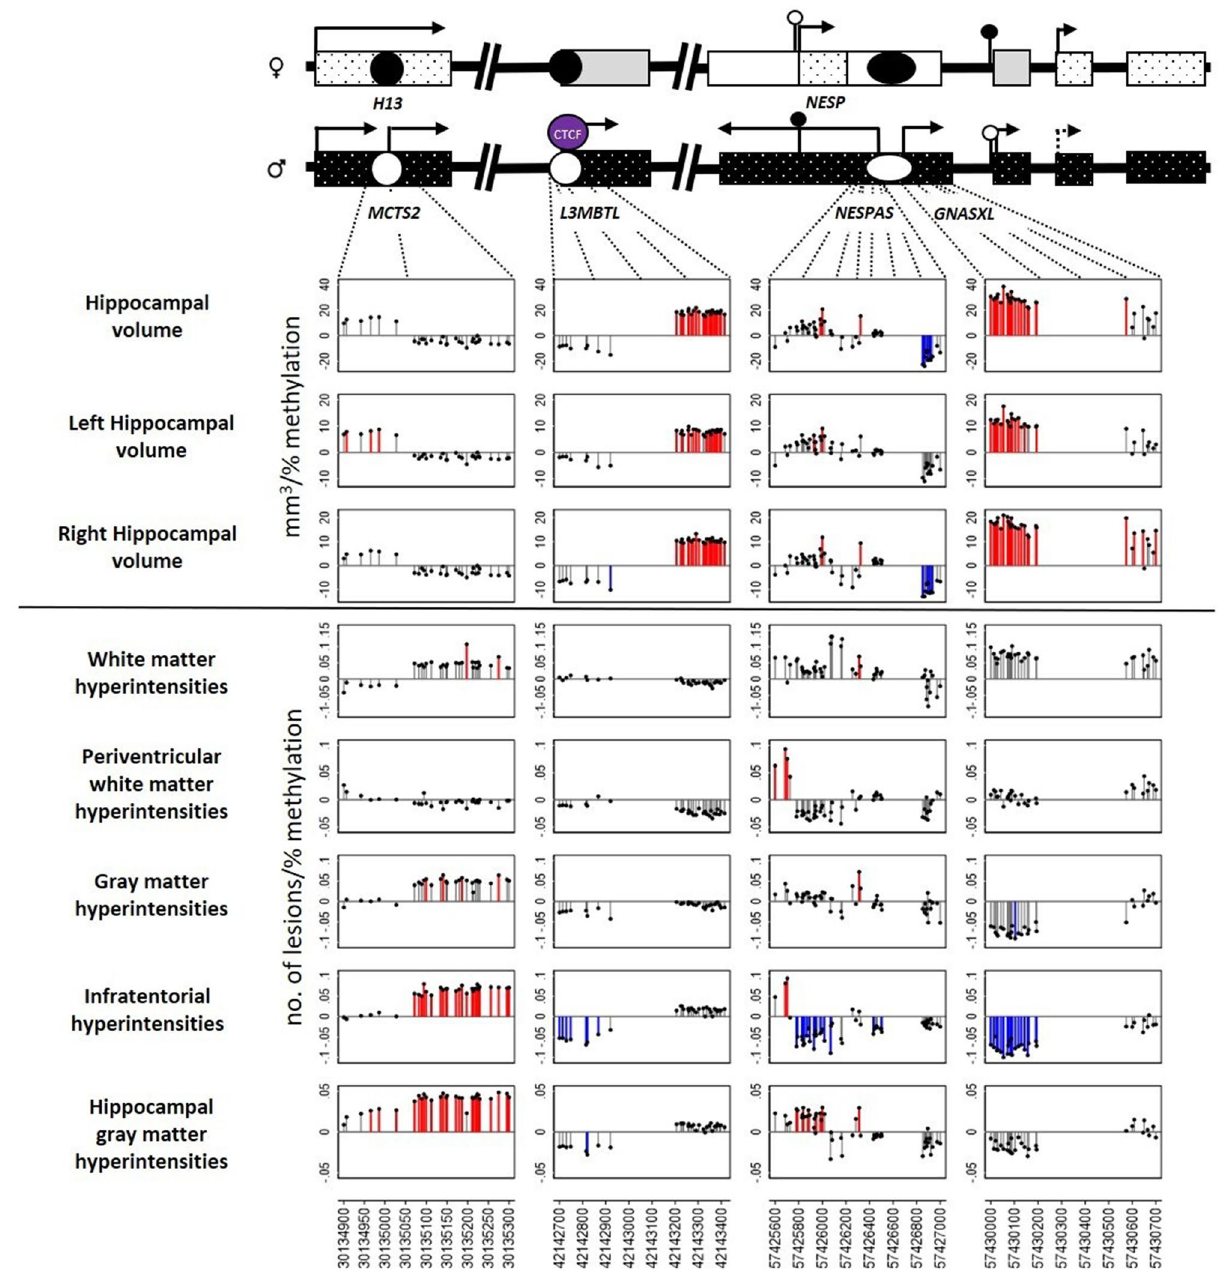
Figure 2. Example coefficient plot for associations between imprint methylation and change in hippocampal volumes and hyperintensities on chromosome 20 ( MCTS2 , L3MBTL , NESPAS , GNASXL ) in ABC36 participants between baseline and follow-up image collection. The schematic at the top of each column of figures shows the genomic location of the individual CpG sites in the context of function on the maternally and paternally inherited alleles (indicated by male and female symbols). The y axes represent the change in hippocampal volume (in mm 3 ) or the change in number of lesions per percent methylation and the x axes genomic location on chromosome 20 (GRCh37, release 84, version of March 2016). Positions significant at p < 0.05 are shown in blue when coefficients are negative and in red when positive. Regressions were adjusted for sex, total intracranial volume, age at baseline (in days) and time between MRI scans (in days). Created using STATA/MP version 15 (StataCorp. 2017. Stata Statistical Software: Release 15 . College Station, TX: StataCorp